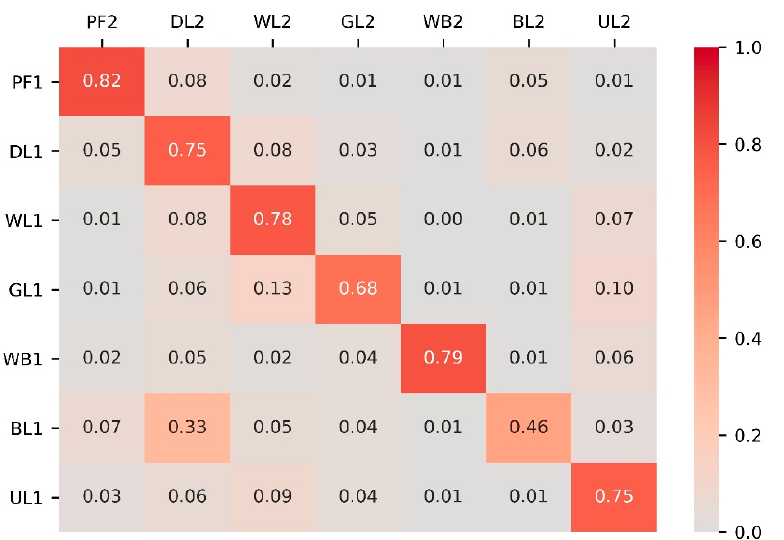
Figure 5. Transition probability matrix of land-use types in Northeast China during 2015–2050. Note: The axes letters have the same meanings as Table 3. The number 1 represents 2015, and 2 represents 2050.